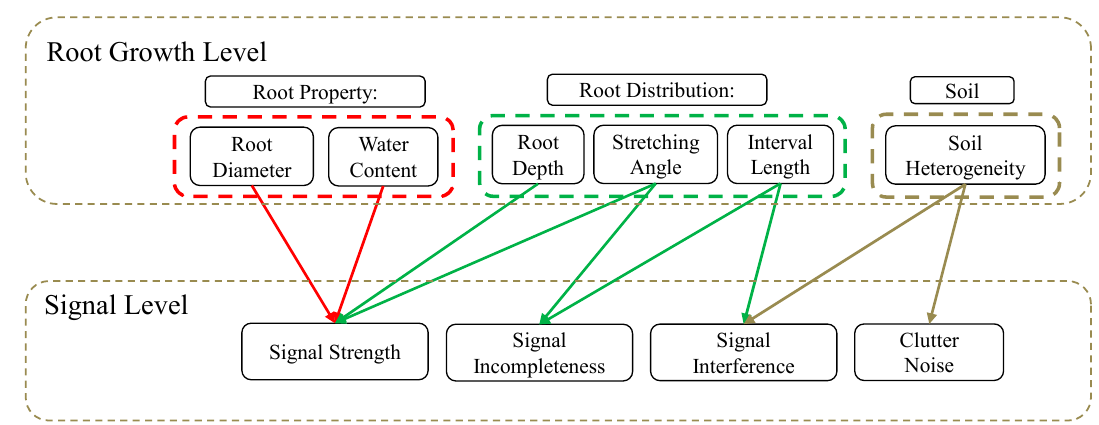
Figure 8. Two levels of the limiting factors for the recognition algorithm based on RHT and the relationship between them.